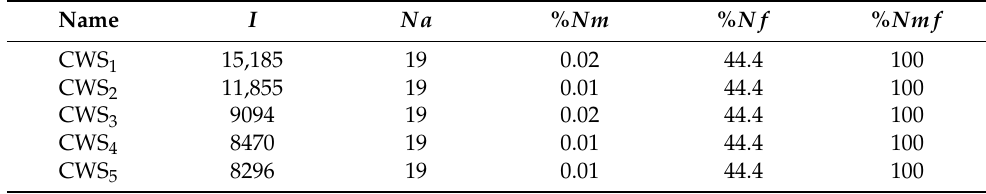
Table 3. Description of the five datasets in the studio